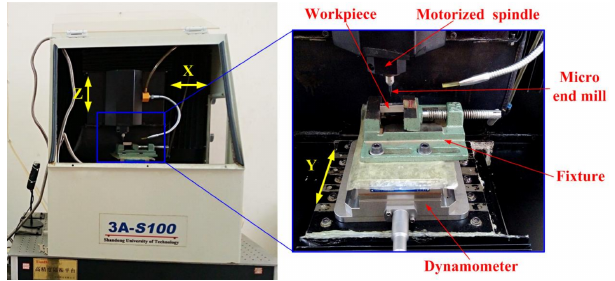
Figure 8. Micro milling machine tool 3A-S100.